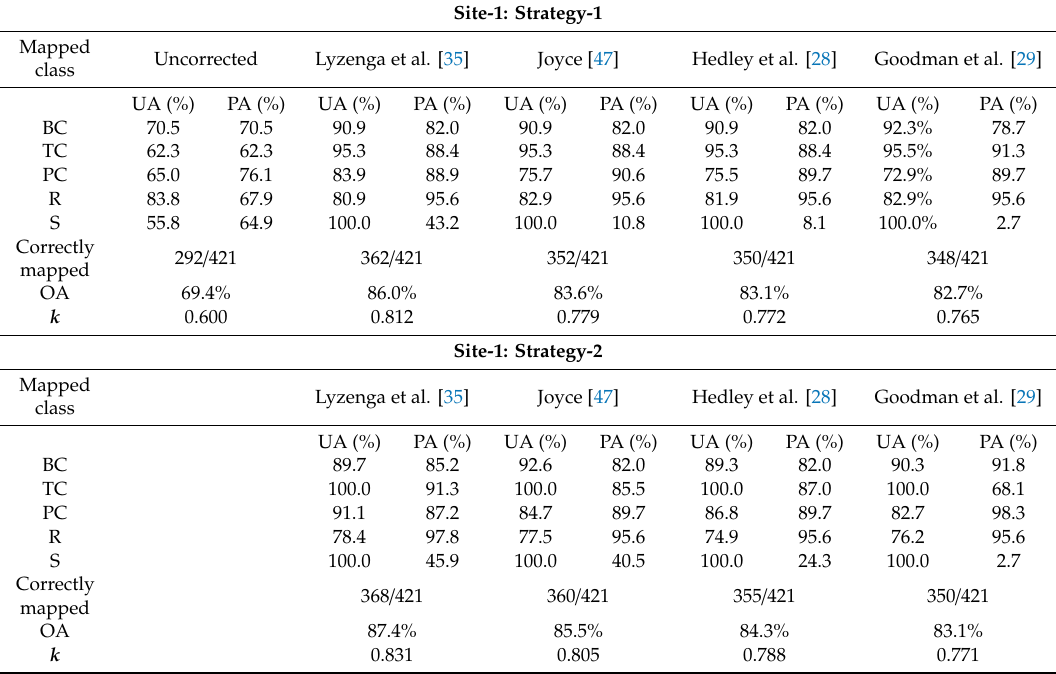
Table 3. Summary of confusion matrices for Site-1 (Pantai Pasir Cina) benthic habitat maps using the sun glint uncorrected dataset, and sun glint-corrected datasets (applying Strategy-1 and Strategy-2). The mapped class abbreviations are as described in Table S2 (Supplementary Materials); BC = branching coral- Acropora ; TC = tabulate coral – Acropora + Montipora ; PC = patch coral; R = coral rubble; S =